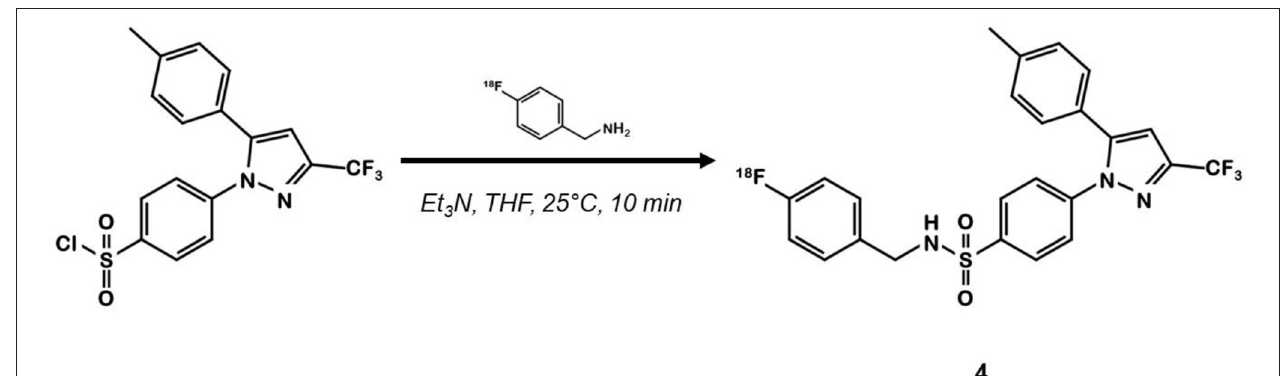
FIGURE 3 | Radiosynthesis of pyrazole derivative 18 F-4.